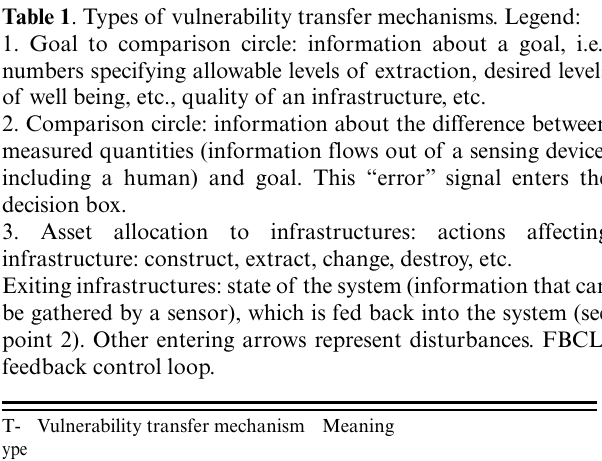
Table 1 . Types of vulnerability transfer mechanisms. Legend: 1. Goal to comparison circle: information about a goal,